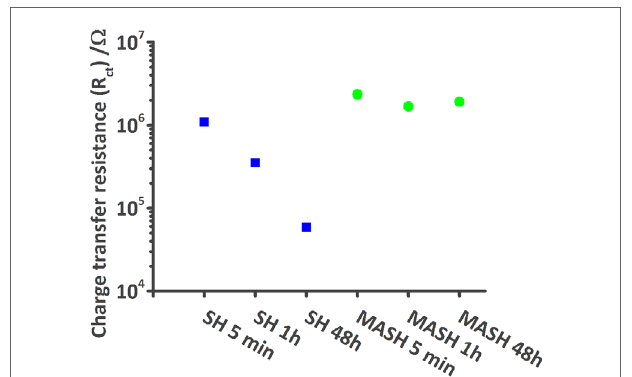
FigUre 5 | Plot shows the decrease of the modeled charge transfer resistance values of the sh reference sample (blue squares) during 48 h in comparison with the more or less constant values of the Mash sample (green dots) .